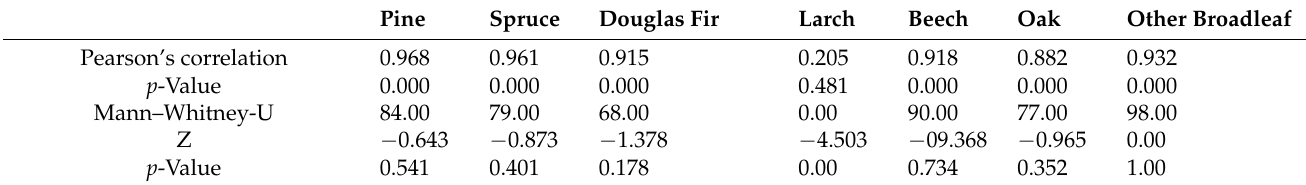
Table 4. Results of the Mann–Whitney-U-Test for percentage of area covered by each main tree